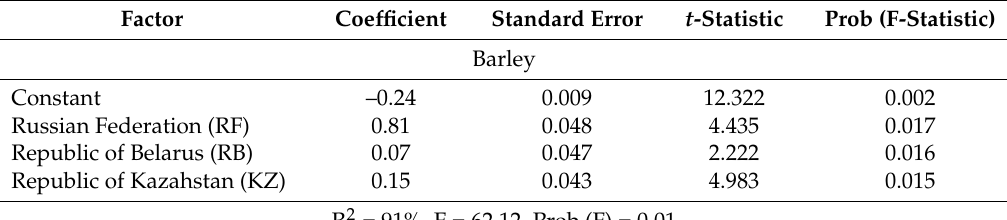
Table 4. The results of the comparison of the level of barley competitiveness of the EAEU countries based on regression analysis from 2010 to 2016.